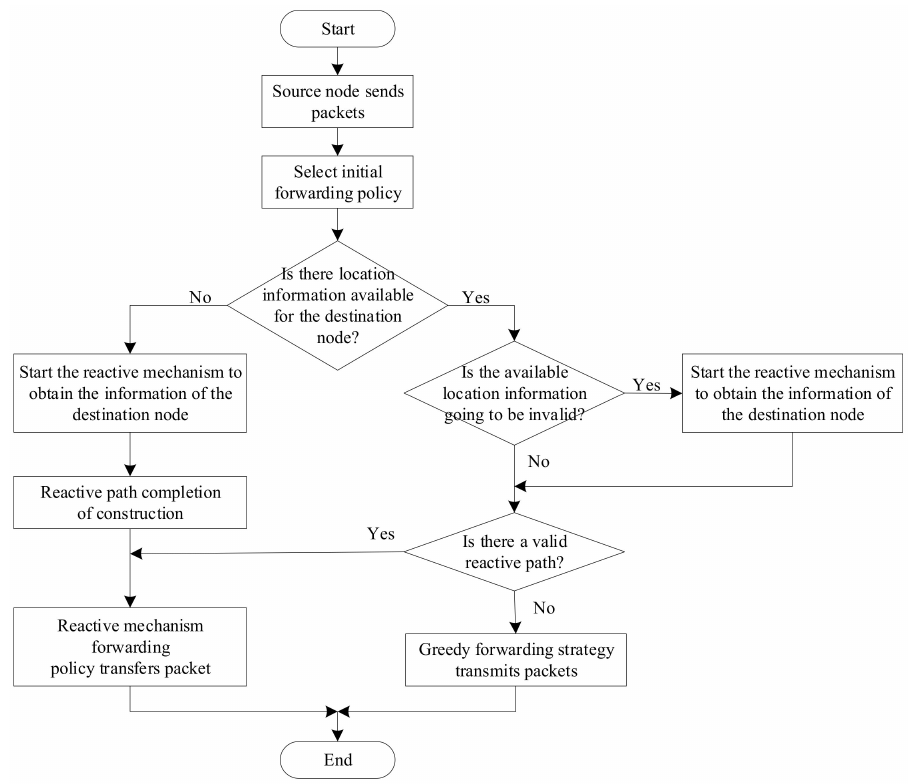
Figure 5. The process by which the source node selects the forwarding